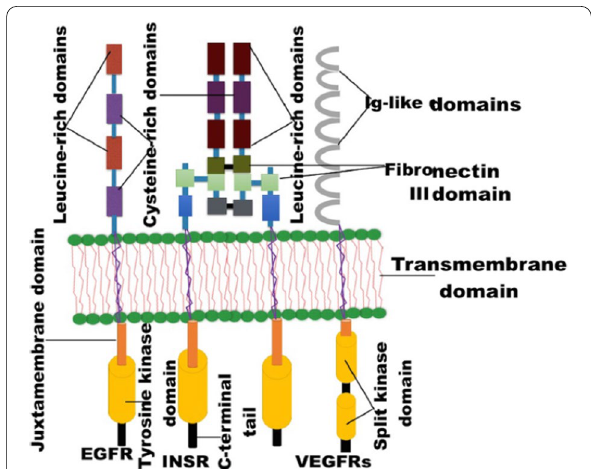
Fig. 1 Structural representation of the RTKs subfamilies. The extracellular ligand binding region differs across RTKs subfamilies, including immunoglobulin (Ig)-like or epidermal growth factor (EGF)-like domains, fibronectin type III repeats, and cysteine/ leucine-rich regions. The single-pass transmembrane is linked to the intracellular tyrosine kinase domain (TKD) by the juxtamembrane. When extracellular ligands or a growth factor binds to the extracellular domain, it stimulates dimerization with neighboring RTKs. Dimerization leads to activation of the catalytic site within the TKD. Thus, autophosphorylation occurs as the receptor becomes activated